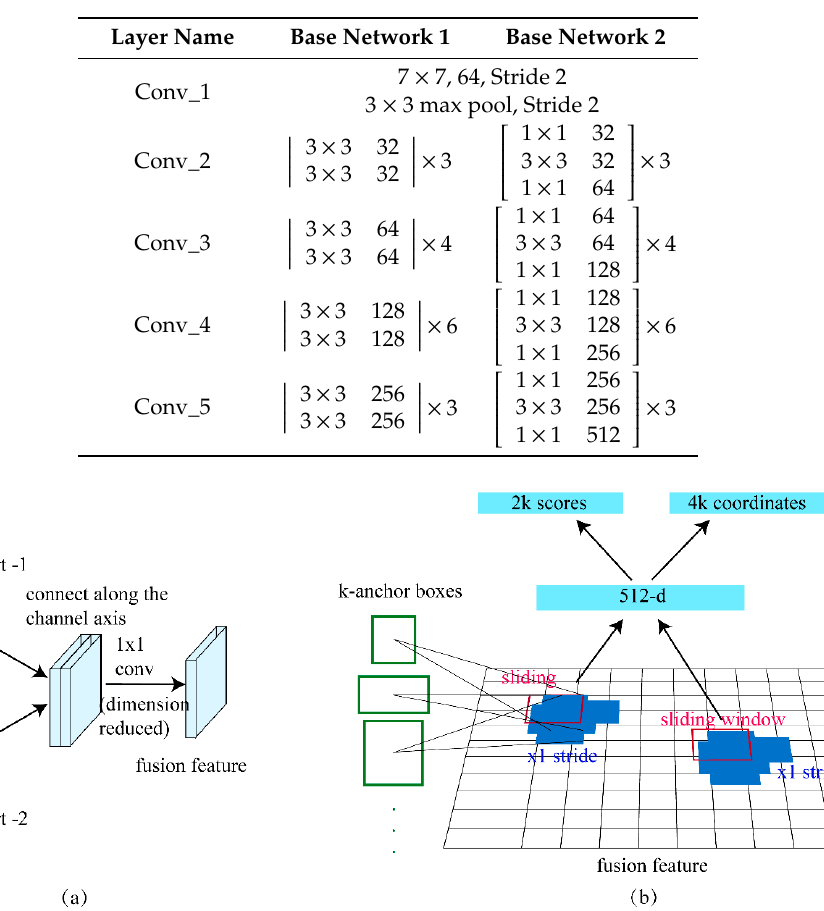
Table 1. Overview of base network.